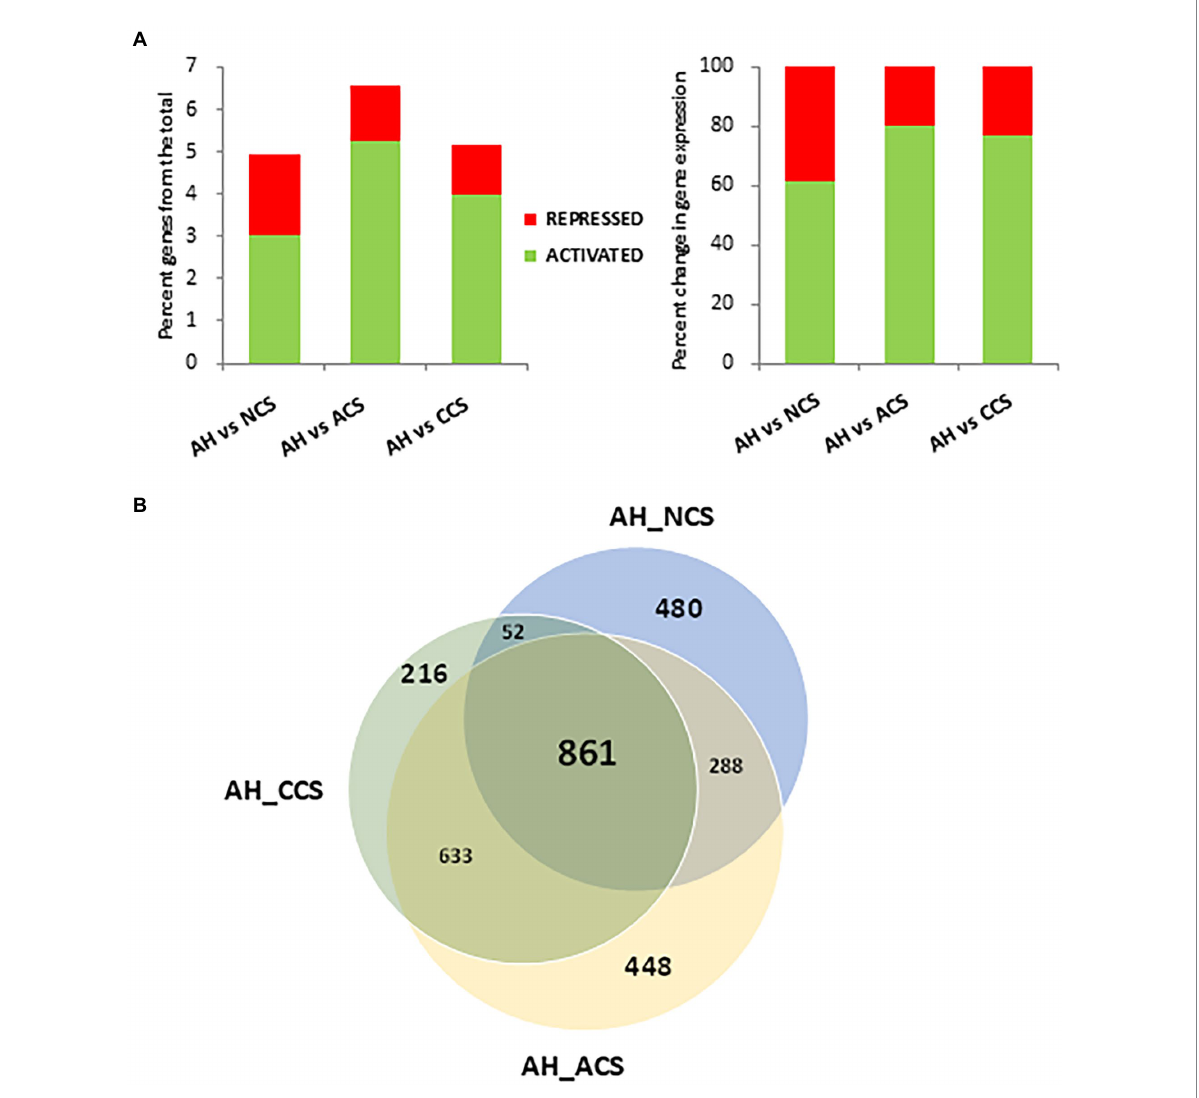
FIGURE 2 Differentially expressed genes (DEGs) analysis among after harvest (AH) and different cold storage conditions. (A) Percentage of differentially activated or repressed genes at global level or among the comparisons: After harvest (AH) vs. non-cold stored (NCS), AH vs. air-cold stored (ACS) and AH vs. CO 2 -cold stored (CCS). (B) Venn diagram showing the number of DEGs in the comparisons, AH vs. NCS, AH vs. ACS and AH vs.